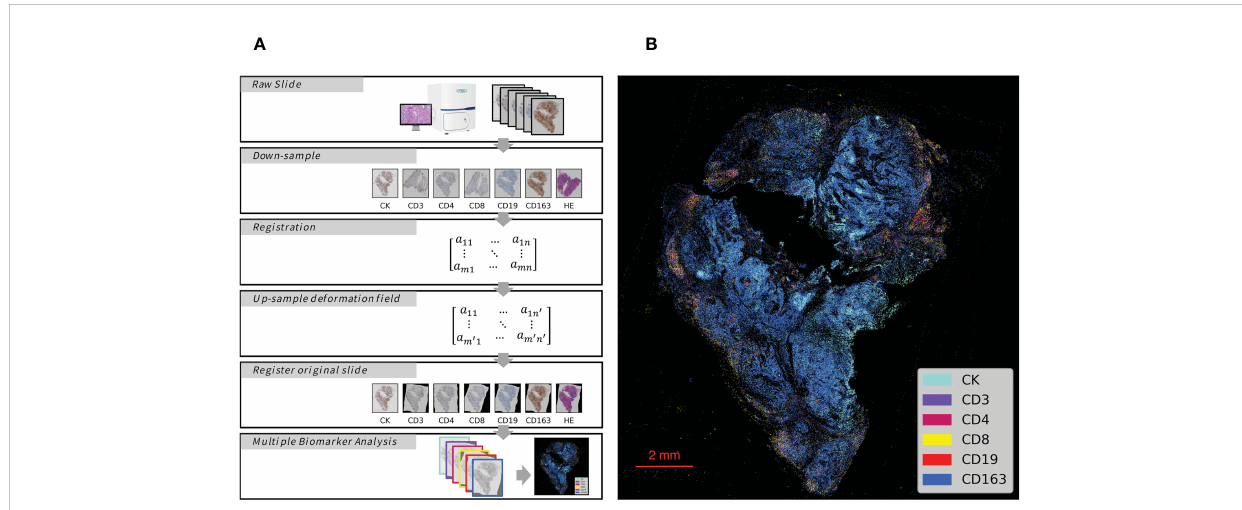
FIGURE 1 Schematic Overview of IHC Series Imaging, Registration and Multiplex Visualization. (A) Whole-Slide Digital Images representing serial sections enable assessment of immune microenvironment biomarkers. The images were down-sampled to a 500 pixels × 500 pixels size and then registered to the target images to generate deformation fi elds. The original size digital images were fi nally registered with up-sampled deformation fi elds, and thus serial sections identifying different biomarkers were spatially aligned to study the distributions of multiple immune cells. (B) Integrated visualization of serial sections by pseudo-coloring. Biomarkers and colors are shown on the right. The gray arrows indicated analytical steps that moves forward.